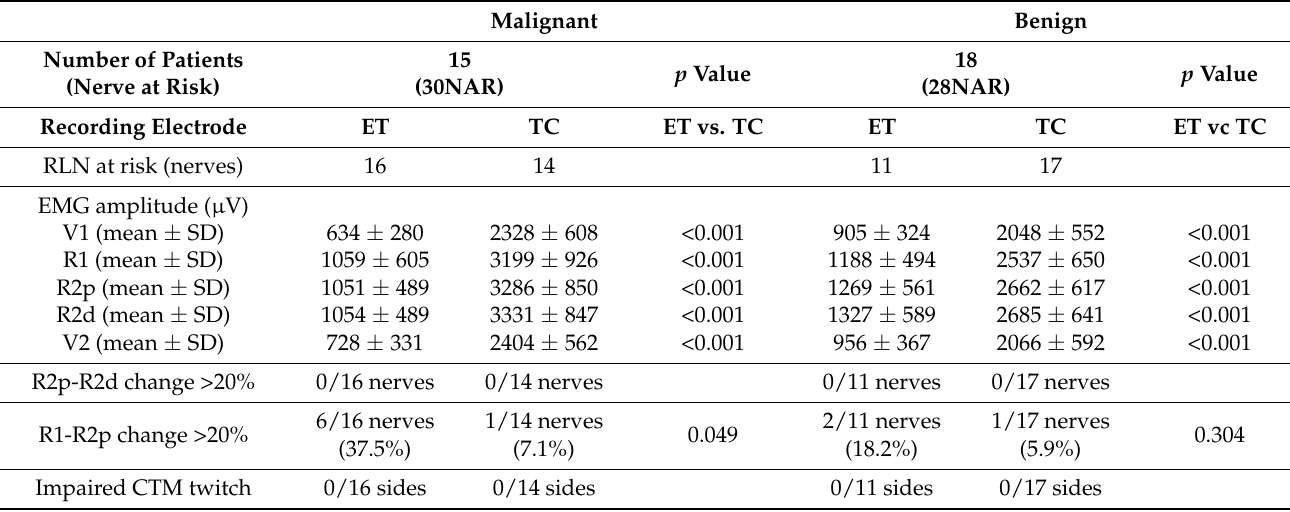
Table 2. Comparison between intraoperative neuromonitoring information with different recording methods in pediatric patients with malignant and benign thyroid